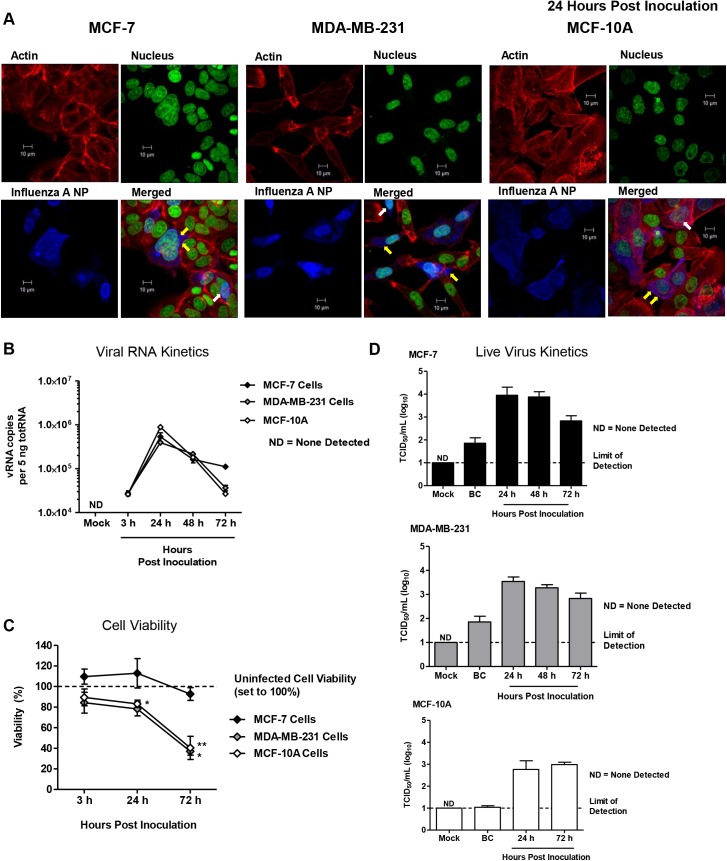
Human “normal” and adenocarcinoma mammary epithelial cells are susceptible and permissive to 2009 H1N1 infection in vitro.Mammary epithelial cells (MCF-7, MDA-MB-231, MCF-10A cells) inoculated at an MOI of 1 with A/Cal (H1N1) were fixed at 24 hours post-inoculation and stained for filamentous actin (red), DNA (green), and influenza A virus NP protein (blue), and imaged by confocal microscopy (A). Mammary epithelial cells (MCF-7, MDA-MB-231, MCF-10A cells) inoculated at an MOI of 1 with A/Cal (H1N1) were collected at 3, 24, 48, and 72 h post-inoculation for quantification of viral RNA segment 7 by qRT-PCR (B), determination of cell viability (C), and live virus quantification in supernatant (D). Confocal pictures are representative of three independent experiments. White arrows indicate nuclear localization of influenza NP protein. Yellow arrows show virus budding along the plasma membrane. BC, Baseline Control.